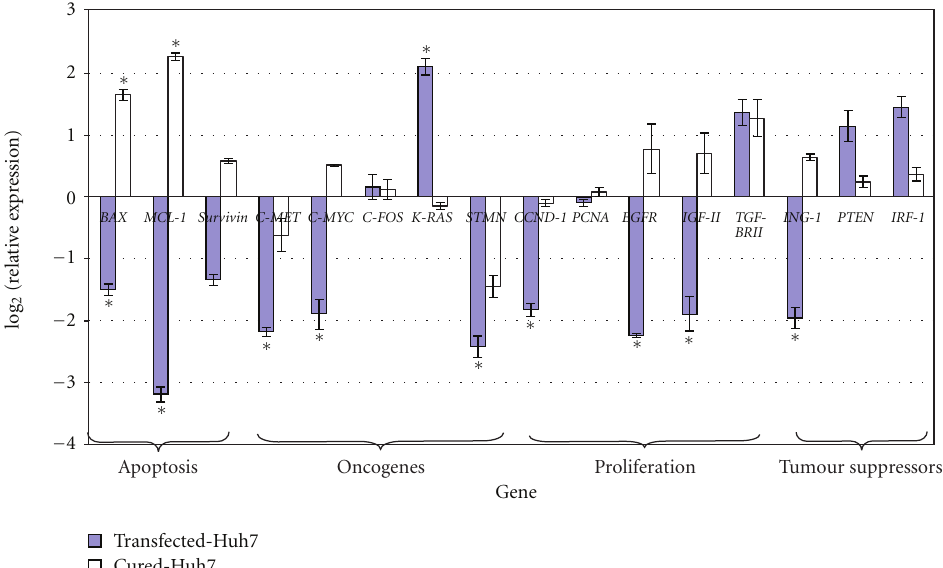
Figure 3: Relative expression of HCC-related genes in transfected- & cured Huh7 cells in response to H. bilis . Values are presented as log 2 of the relative expression and represent the mean relative expression derived from biological triplicates. ∗ P < 0 .